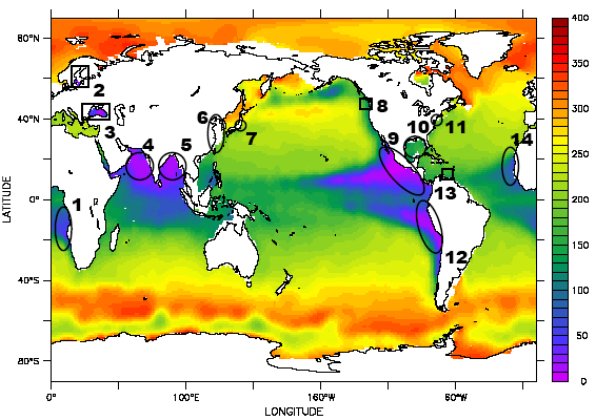
Fig. 1. Mean annual dissolved O 2 concentration (µmolkg − 1 ) at 150m depth. 1 ◦ × 1 ◦ gridded O 2 data were taken from World Ocean Atlas 2005 (Garcia et al., 2006) and converted to µmolkg − 1 . The O 2 -depleted zones discussed in the text are marked: 1, Off SW Africa; 2, Baltic Sea; 3, Black Sea; 4, Arabian Sea; 5, Bay of Bengal; 6, East China Sea; 7, Tokyo Bay; 8, Saanich Inlet; 9, Eastern North Pacific; 10, Gulf of Mexico; 11, Chesapeake Bay; 12, Eastern South Pacific; 13, Cariaco Basin; 14, Off NW Africa. Squares depict semi-enclosed basins that experience sulphate re- duction whereas circles/ovals depict other low O 2 /hypoxic/suboxic (including seasonally anoxic) environments along open